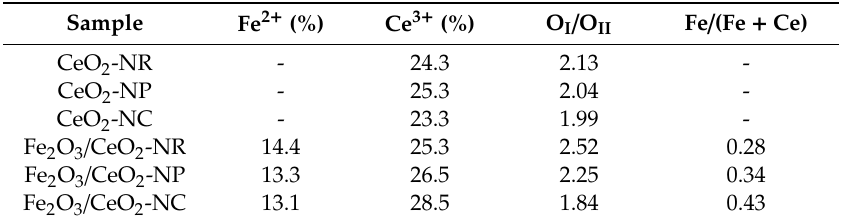
Table 3. XPS results of bare CeO 2 and Fe 2 O 3 / CeO 2